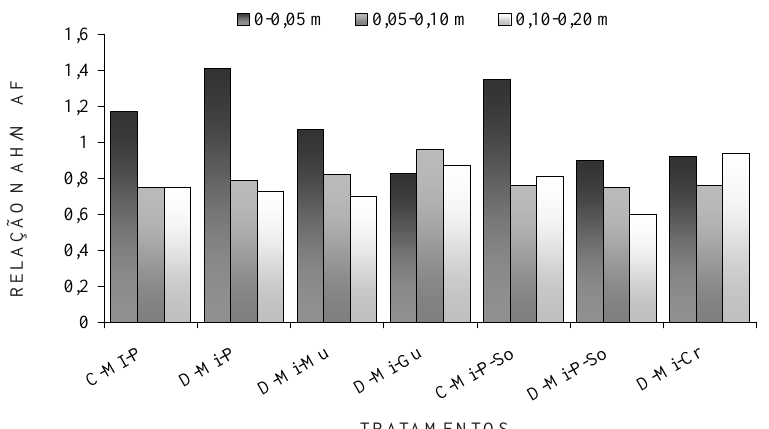
Figura 4. Relação entre o N total no ácido húmico e N total no ácido fúlvico (AH/AF) em um Latossolo Roxo cultivado com diferentes sistemas de produção por seis anos consecutivos. C = sistema de semeadura convencional; D = sistema de plantio direto; Mi = milho semeado no verão; So = soja semeada no verão; P = pousio no inverno; Mu = semeadura de mucuna-preta no inverno; Gu = semeadura de feijão guandu no inverno; Cr = semeadura de Crotalaria juncea no inverno.